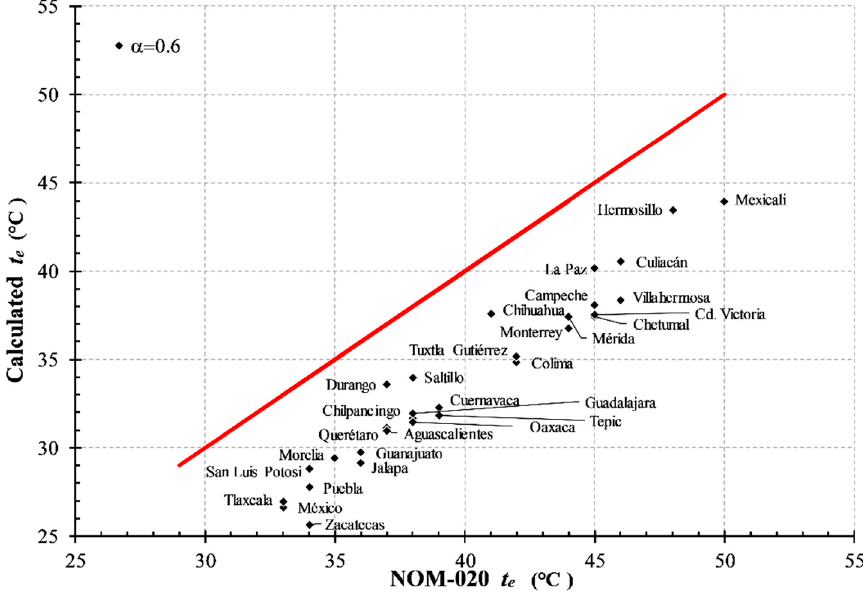
Figure 4. NOM-020-ENER-2011 ( t e ) (black squares) vs calculated ( t e ) (red line), α = 0.6.